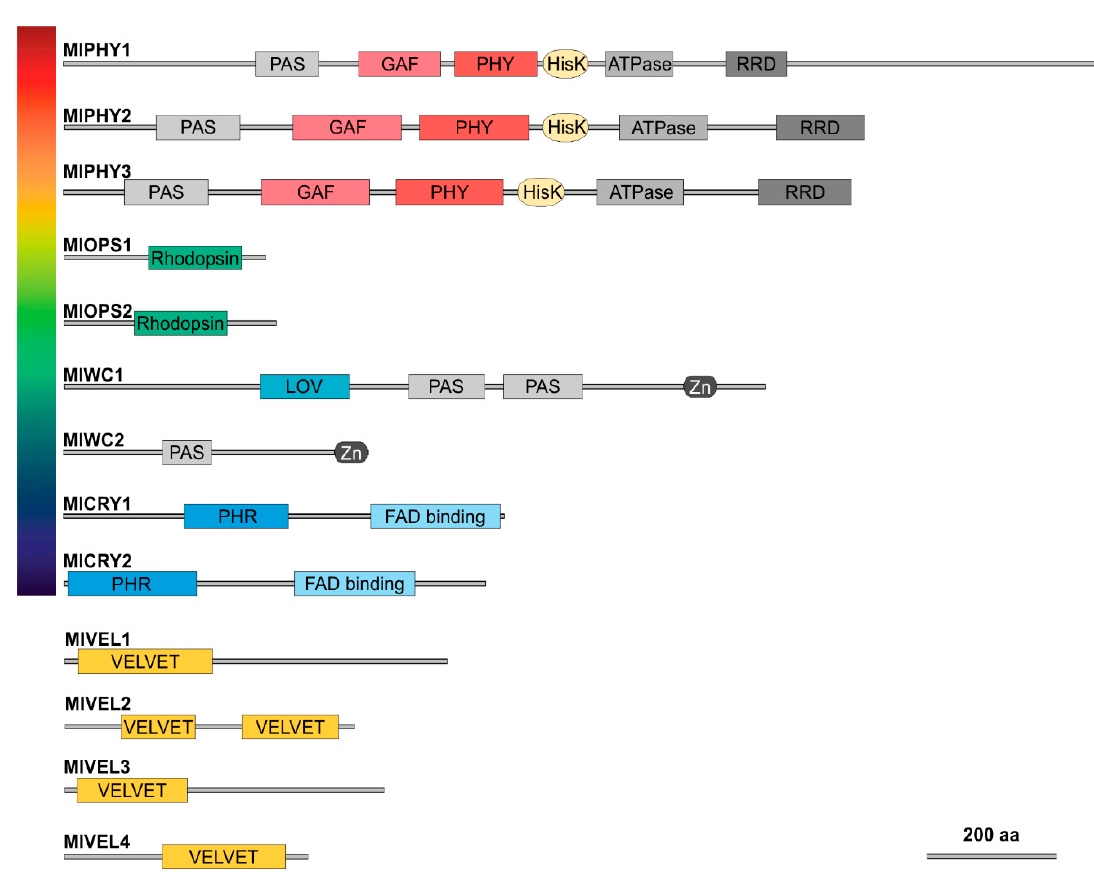
Figure 3. Domain architecture of potential photoreceptors ( top ) and velvet family ( bottom ) proteins in M. laxa . PAS (Per/Arnt/SIM, PF08446); GAF (cGMP-specific phosphodiesterase, PF01590); PHY (phytochrome-specific domain, PF00360); HisK (histidine kinase, PF00512), ATPase domain; RRD (response regulator domain, PF00072); rhodopsin domain (PF01036); LOV (light–oxygen–voltage); Zn (Zing finger domain, PF00320); PHR (Photolyase homology region, PF08005); FAD-binding domain (PF03441); and velvet domain